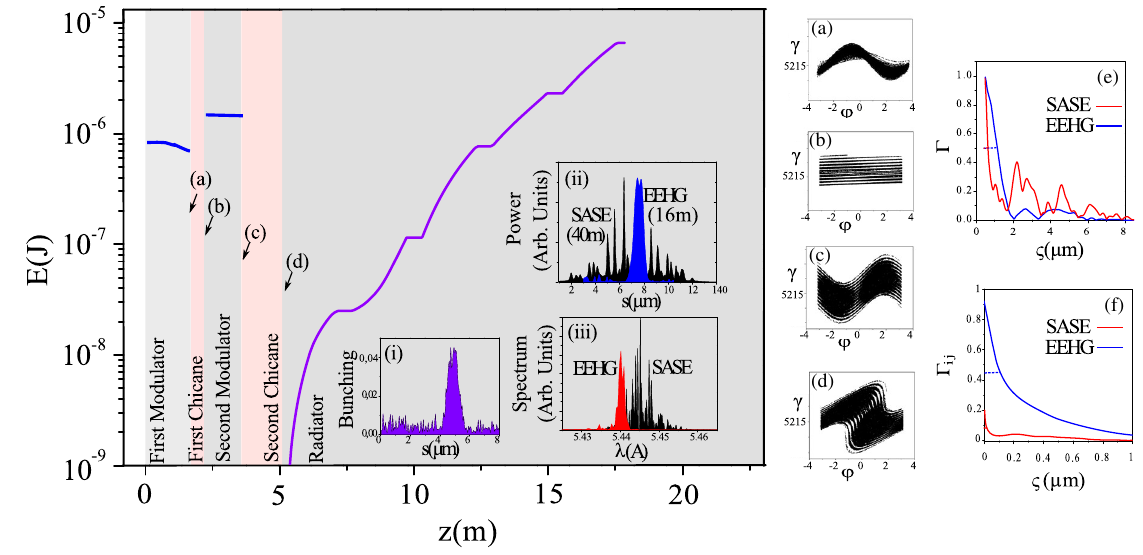
FIG. 3. Radiation energy E ð J Þ vs z(m). In blue, radiation at λ o ¼ 13 . 6 nm in the modulators. In violet, radiation at λ ¼ 13 . 6 = 25 nm ¼ 5 . 44 Å in the radiator. Point (a) is the 1st modulator end, (b) 1st chicane end, (c) 2nd modulator end and (d) 2nd chicane end. Inner figures: (i) bunching on the 25th harmonics at the end of the 2nd chicane, (ii) power density, (iii) spectral amplitude (SASE at 40 m and EEHG at the radiator exit). Windows (a), (b), (c), (d): electron phase space, electron Lorentz factor γ vs seed phase φ , in the corresponding points. (e) and (f): SASE (red) and EEHG (blue) coherence degree for one pulse Γ and for different pulses Γ ij vs ς ¼ c τ . Dotted segments: FWHM coherence lengths.